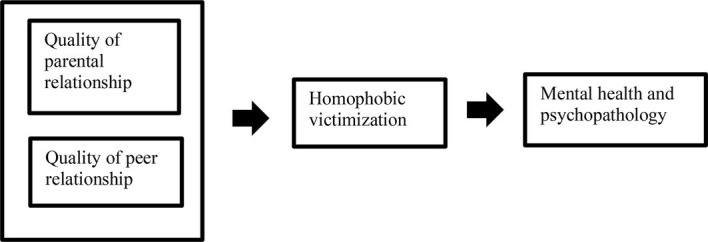
Hypothesized model.